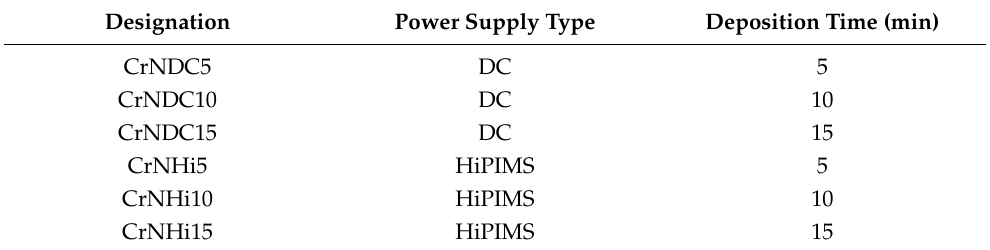
Table 1. Sample designations by power supply type and deposition